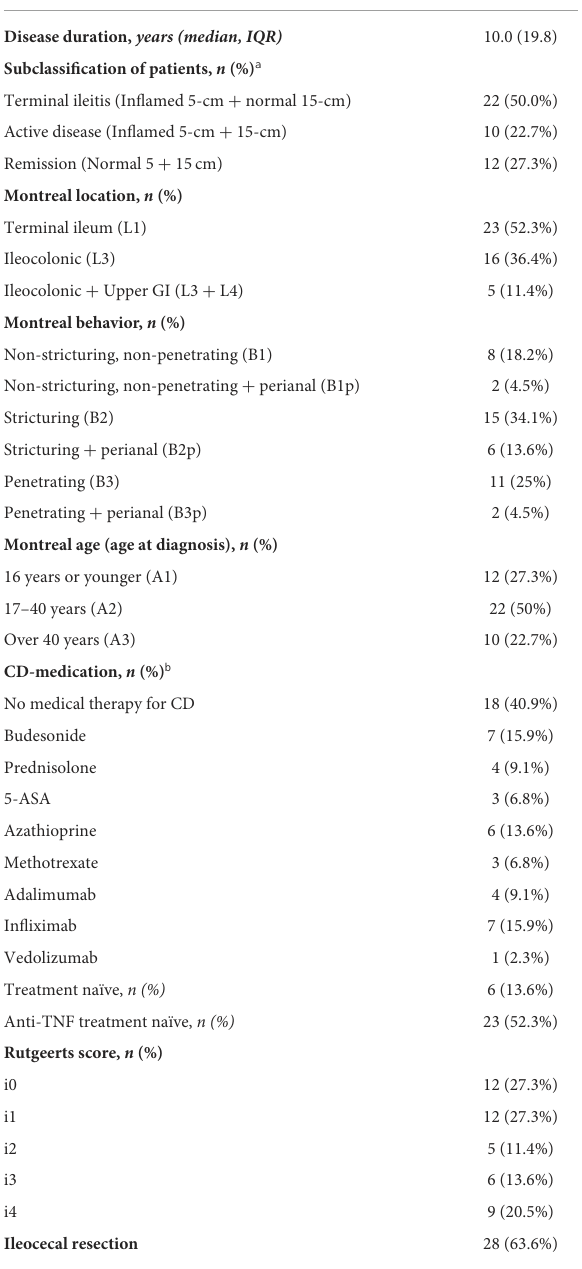
TABLE 2 Crohn’s disease (CD) characteristics, medical treatment, endoscopic evaluation, and surgical history. CD